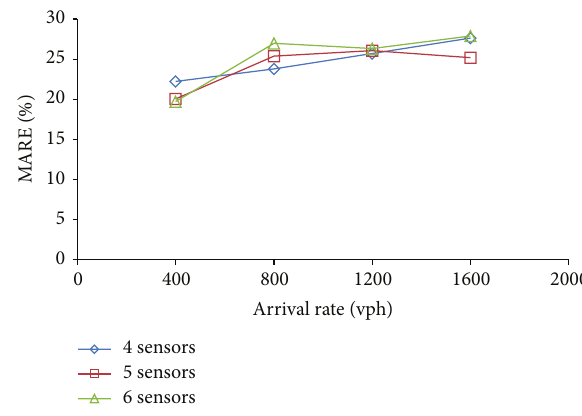
Figure7:ComparisonamongMAREindifferentnumberofsensors for synchronized traffic